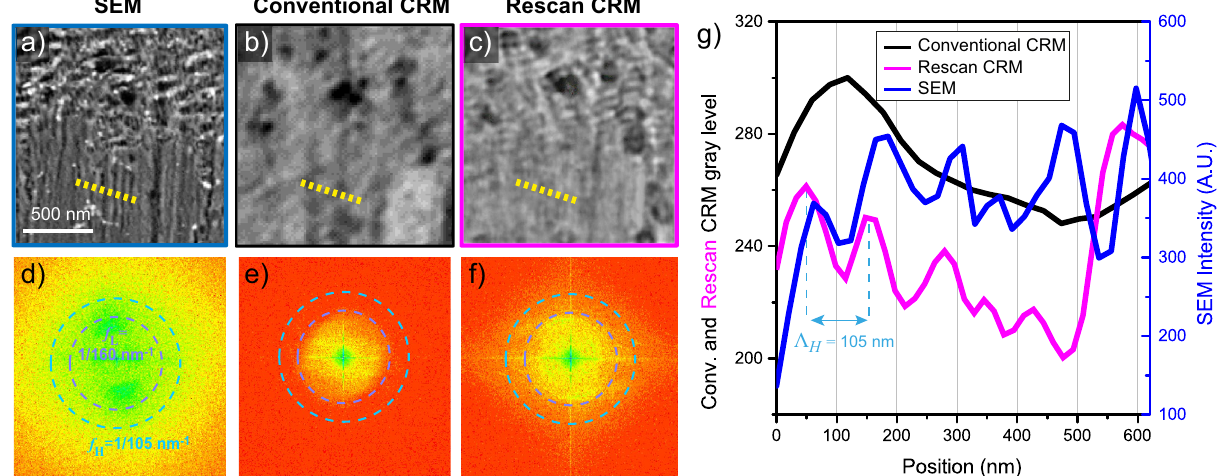
Figure 4. HSFL over titanium alloy surface created by fs laser ( (cid:31) i = 257 nm) and analyzed with different imaging techniques, including their frequency representation. ( a ) SEM, ( b ) conventional CRM, ( c ) re-scan CRM, ( d ) frequency representation of ( a ), ( e ) frequency representation of ( b ), ( f ) frequency representation of ( c ), ( g ) plot of the transversal cut shown in ( a–c